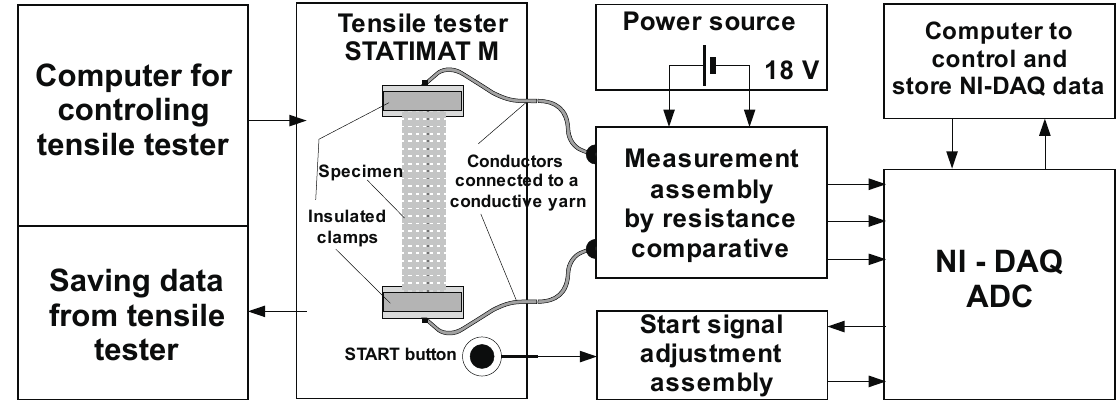
Figure 4. System for measuring changes in the electrical resistance of woven conductive yarns.